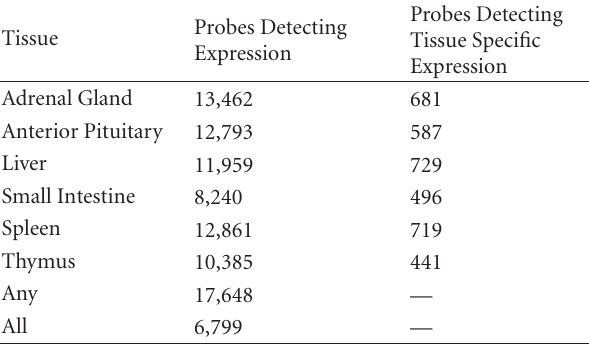
Table 1: Bovine Oligonucleotide Microarray probes with statisti- cally significant